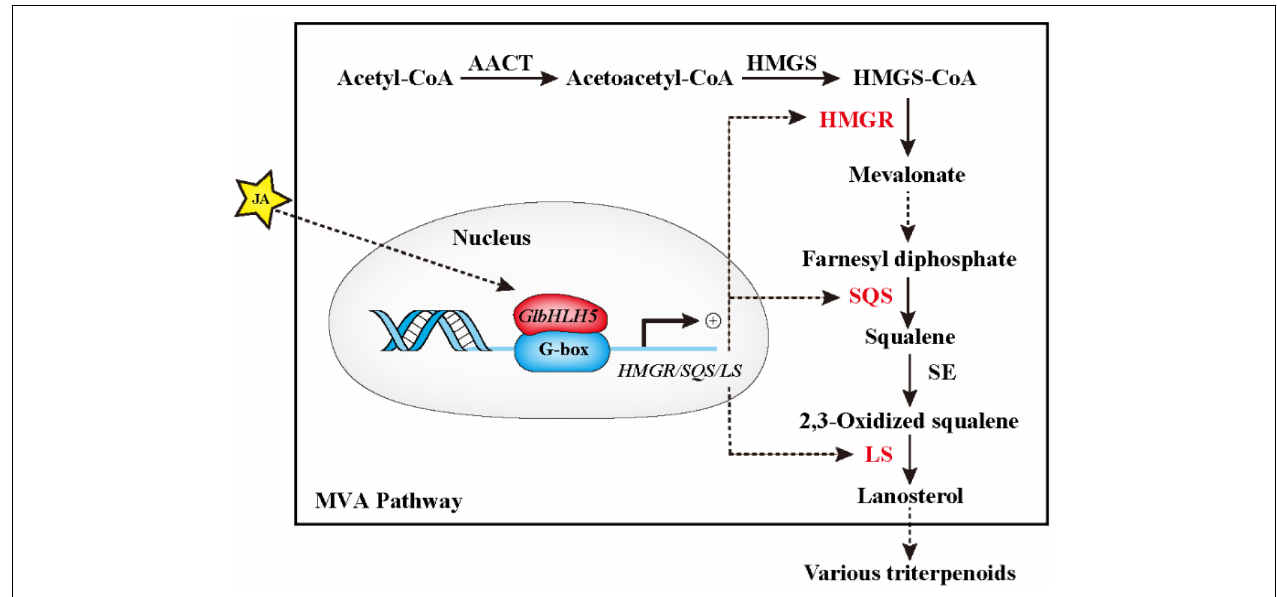
FIGURE 8 | Schematic of the predicted regulatory effect of GlbHLH5 in Ganoderma triterpenoids biosynthesis. The solid box represents the main pathway (MVA pathway) of Ganoderma triterpenoids. AACT, acetyl-CoA acetyltransferase; HMGS, 3-hydroxy-3-methylglutaryl-CoA synthase; HMGR, 3-hydroxy-3-methylglutaryl-CoA reductase, SQS, squalene synthase; SE, squalene monooxygenase; LS, lanosterol synthase.